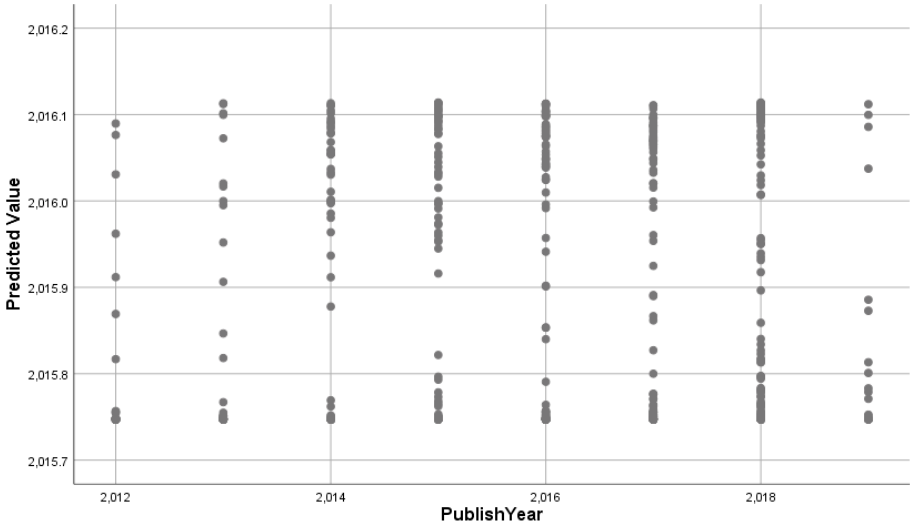
Figure 2. Predicted by the observed chart for the publish year variable.